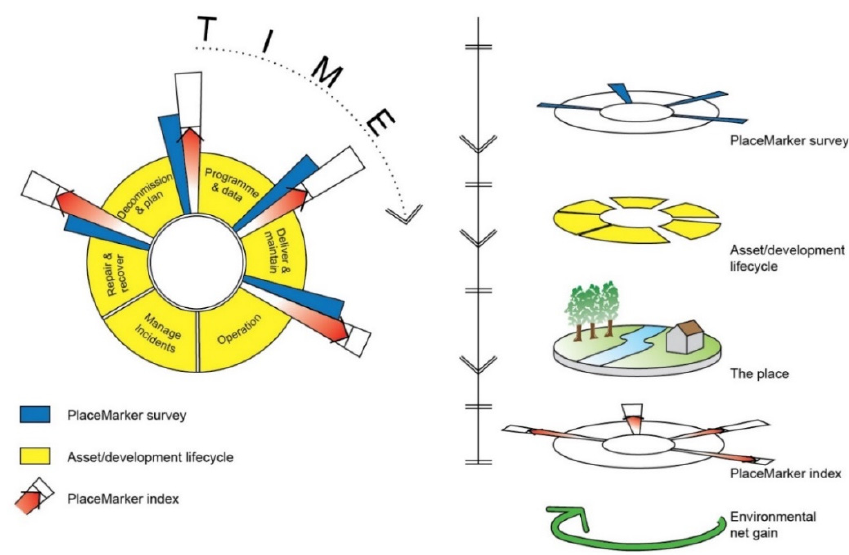
Figure 1. A conceptual model of the PlaceMarker Survey (figure by Mark